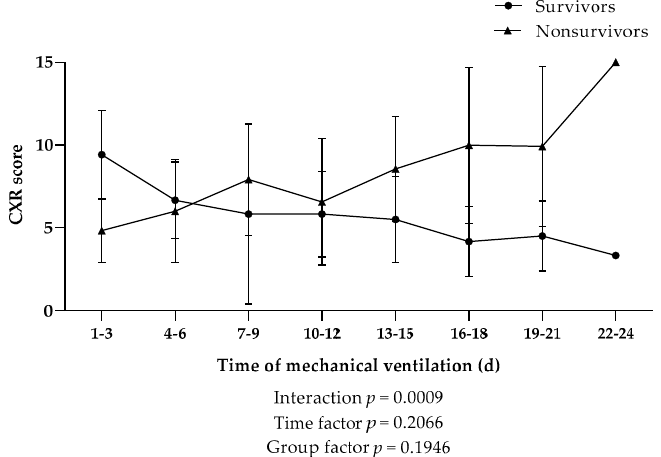
Figure 5. Kinetics of the chest X-ray (CXR) score during the course of mechanical ventilation in